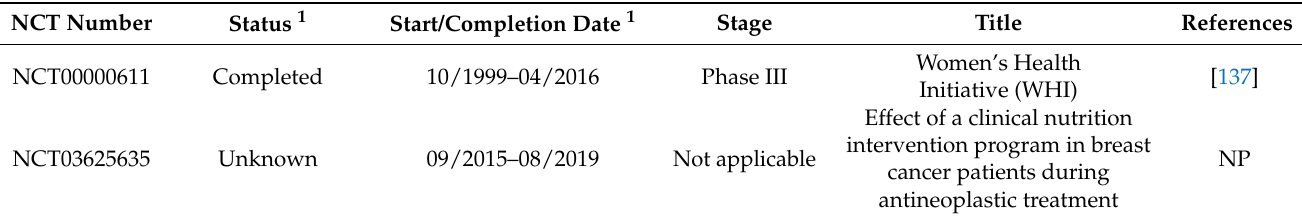
Table 7. Clinical trials with carotenoids in breast